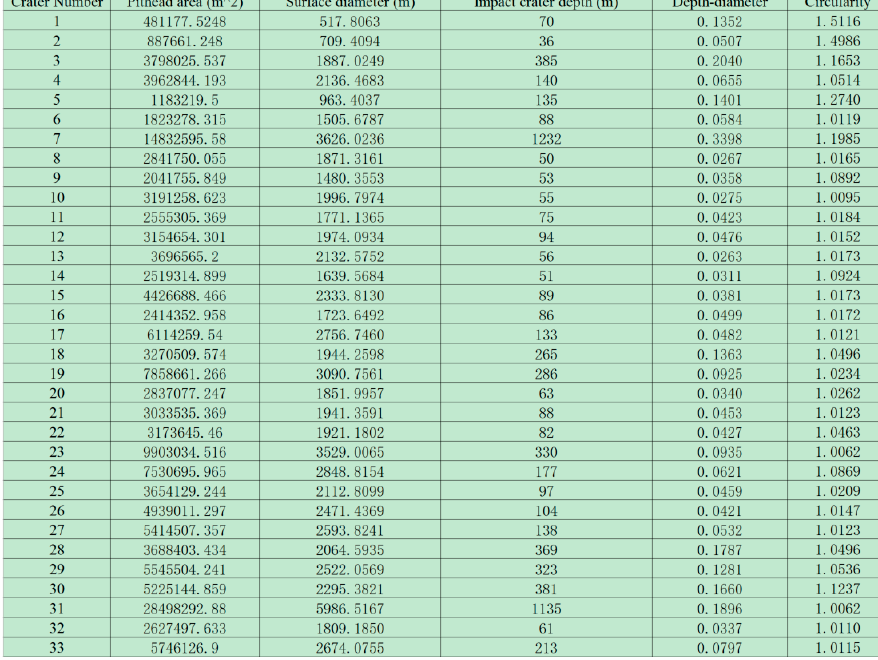
Figure 18. A section of the detection results in region D with its index description.